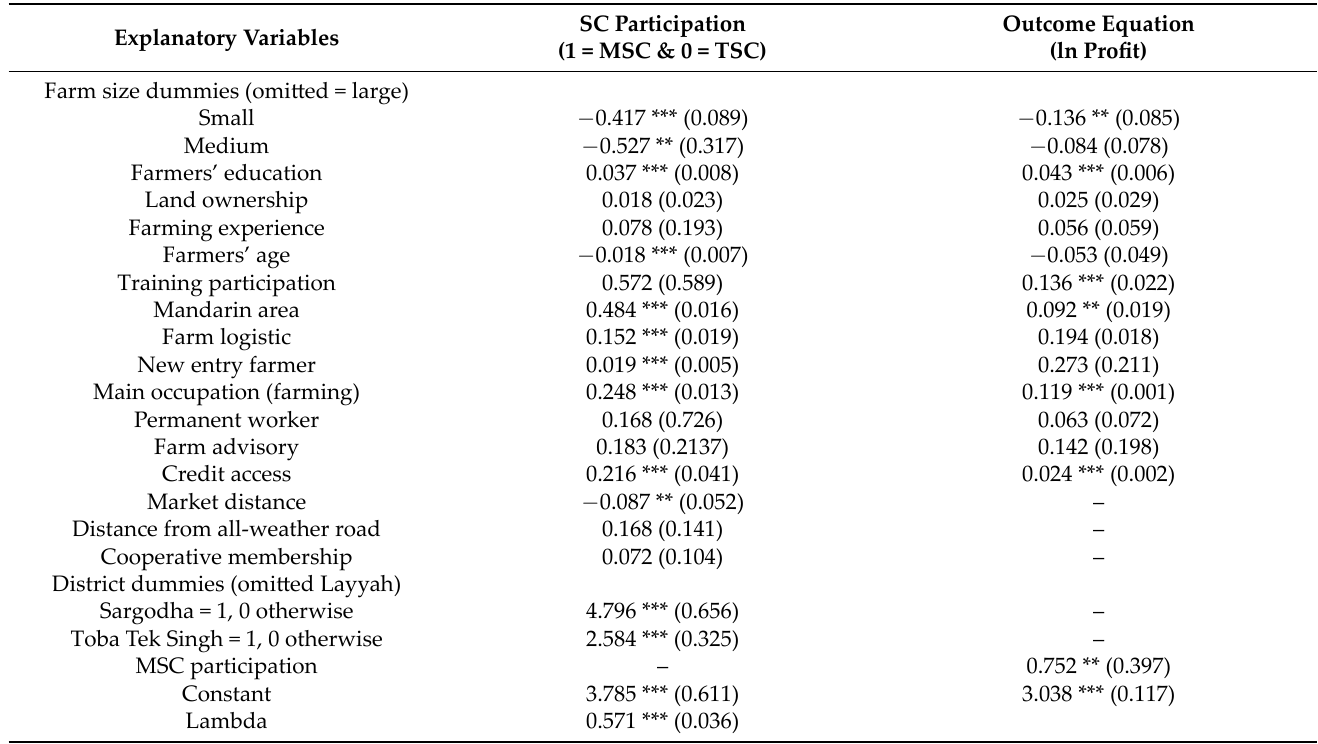
Table 4. Endogenous treatment effect model estimate for SC participation and